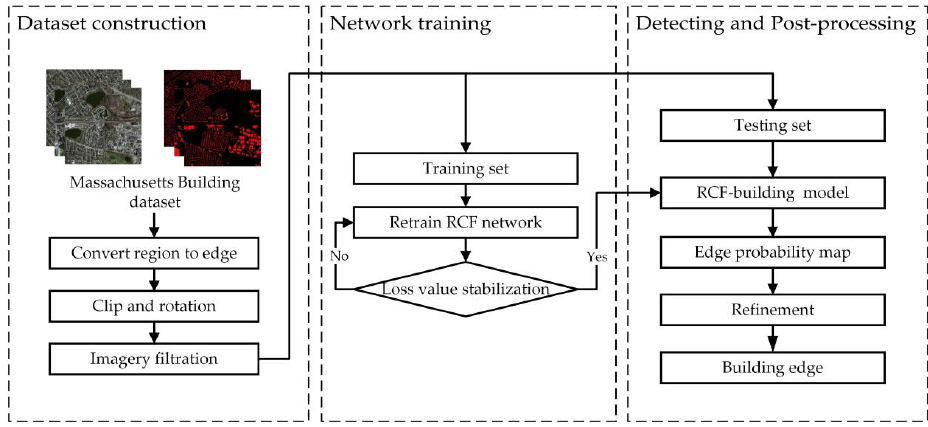
Figure 1. Workflow of fine-tuning RCF network.